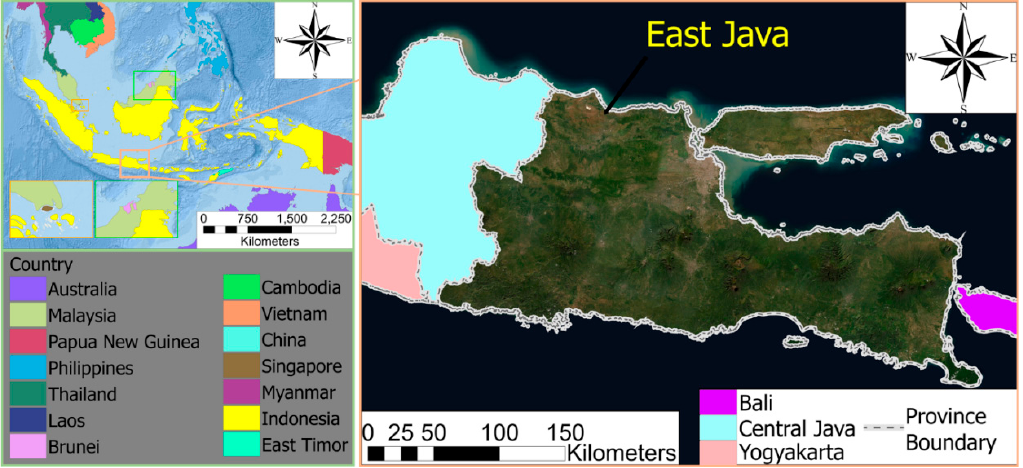
Figure 1. Research location in East Java, Indonesia.